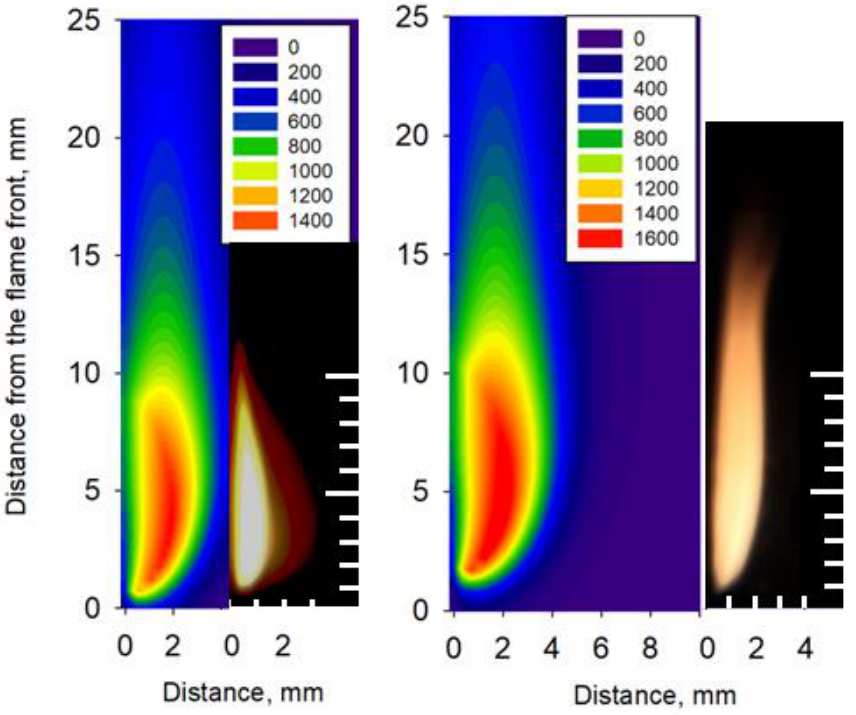
Figure 11. Comparison of the calculated temperature field and the photograph of the flame during the experiment. h = 0.3 mm, 25% O 2 ( left ) and 30% O 2 ( right ).